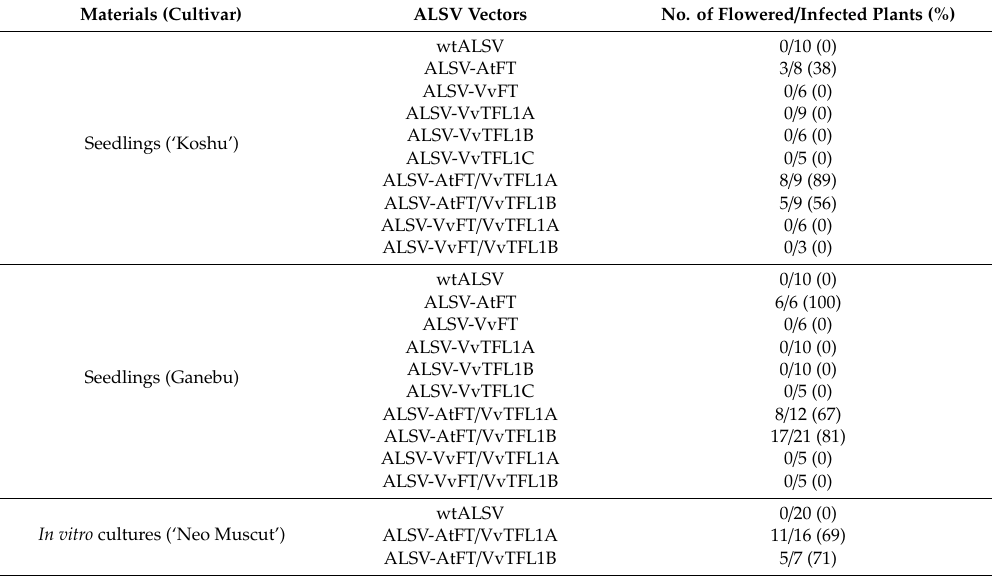
Table 2. Precocious flowering of the seedlings and in vitro cultures of grapevine infected with ALSV vectors possessing FT and / or VvTFL1 sequences *.